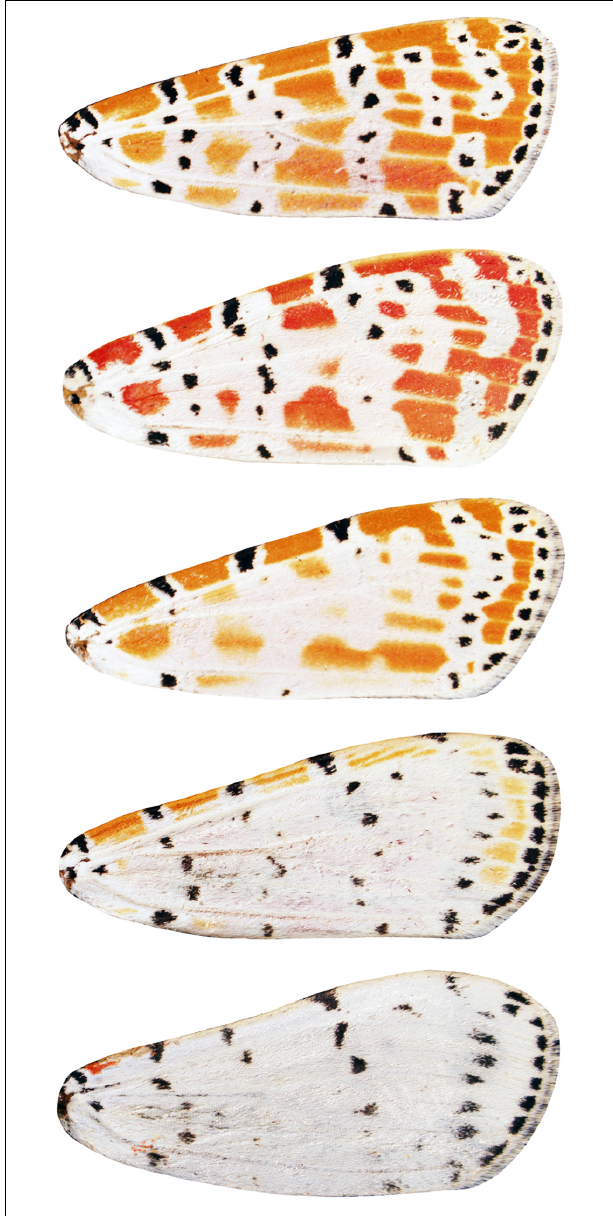
FIGURE 4 | Selection for intensified venous striping in Utetheisa ornatrix . Over the course of four generations, we artificially selected for more pronounced venous stripes in U. ornatrix . The animals initially selected for use in the experiment had modest white stripes that did little more than outline the contours of the veins, similar to those shown at the top of the figure. The offspring of these animals sometimes showed more pronounced venous striping that began to invade the intervenous regions of the wing. These animals were allowed to mate with one another, and any animals remaining from the previous generation. We continued to apply this directional selective pressure for two additional generations, resulting in a further intensification of the venous striping in some animals. The selection regime occasionally produced animals that were almost pure white overall (bottom), with few of the primary black spotted elements remaining. This experiment reveals that details such as venous stripes have the ability to become the most prominent feature of the pattern. Some of the animals shown are also depicted in Figure 1 of Gawne and Nijhout (2019).